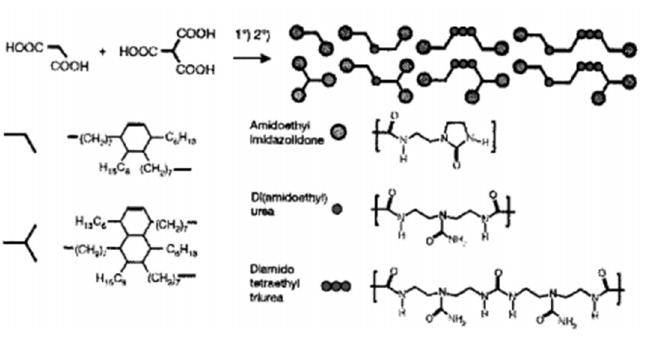
Figure 7. Schematic illustration and molecular structures of the self-healing rubber materials based on fatty D-I Acid and Tr-I Acid.